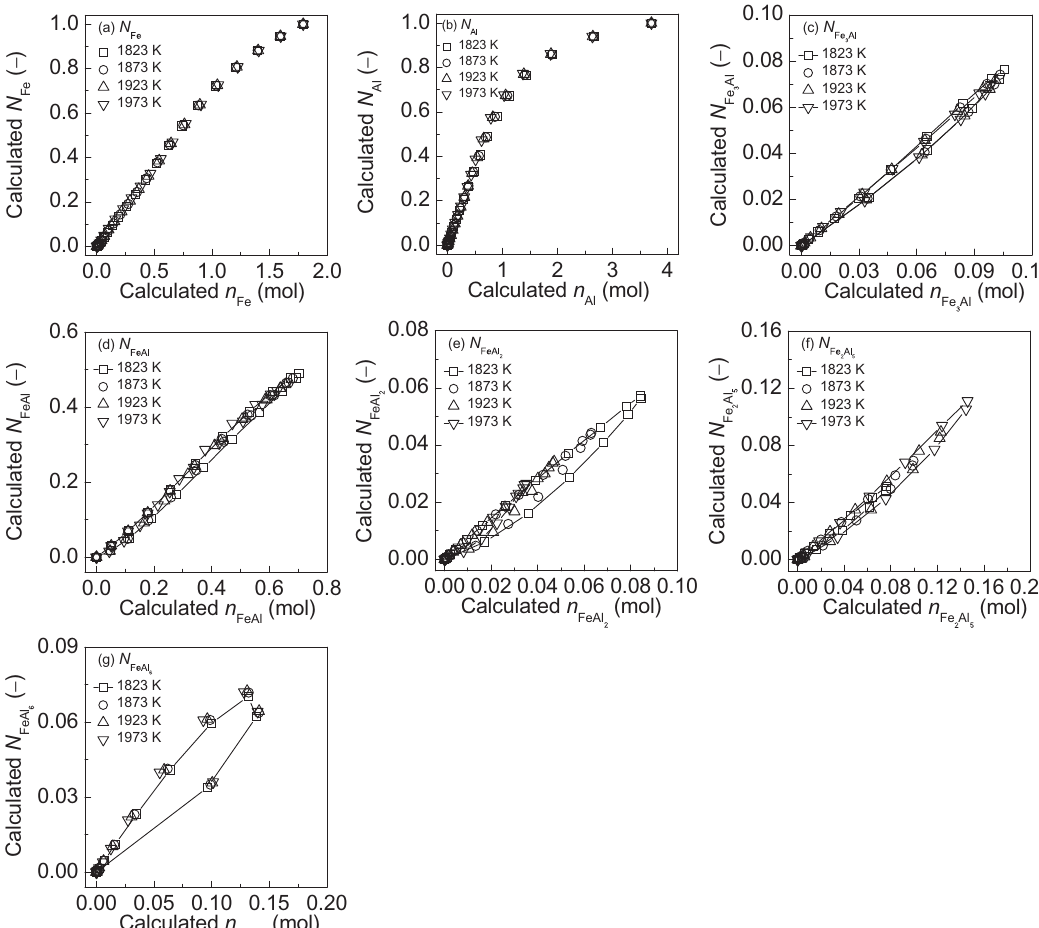
Figure 16: Relationship between calculated mass action concentration N i and calculated equilibrium mole number n i for seven structural units as Fe (a), Al (b), Fe 3 Al (c), FeAl (d), FeAl 2 (e), Fe 2 Al 5 (f), and FeAl 6 (g) in full composition range of Fe – Al binary melts at four temperatures of 1823, 1873, 1923, and 1973 K (1550, 1600, 1650, and 1700°C),